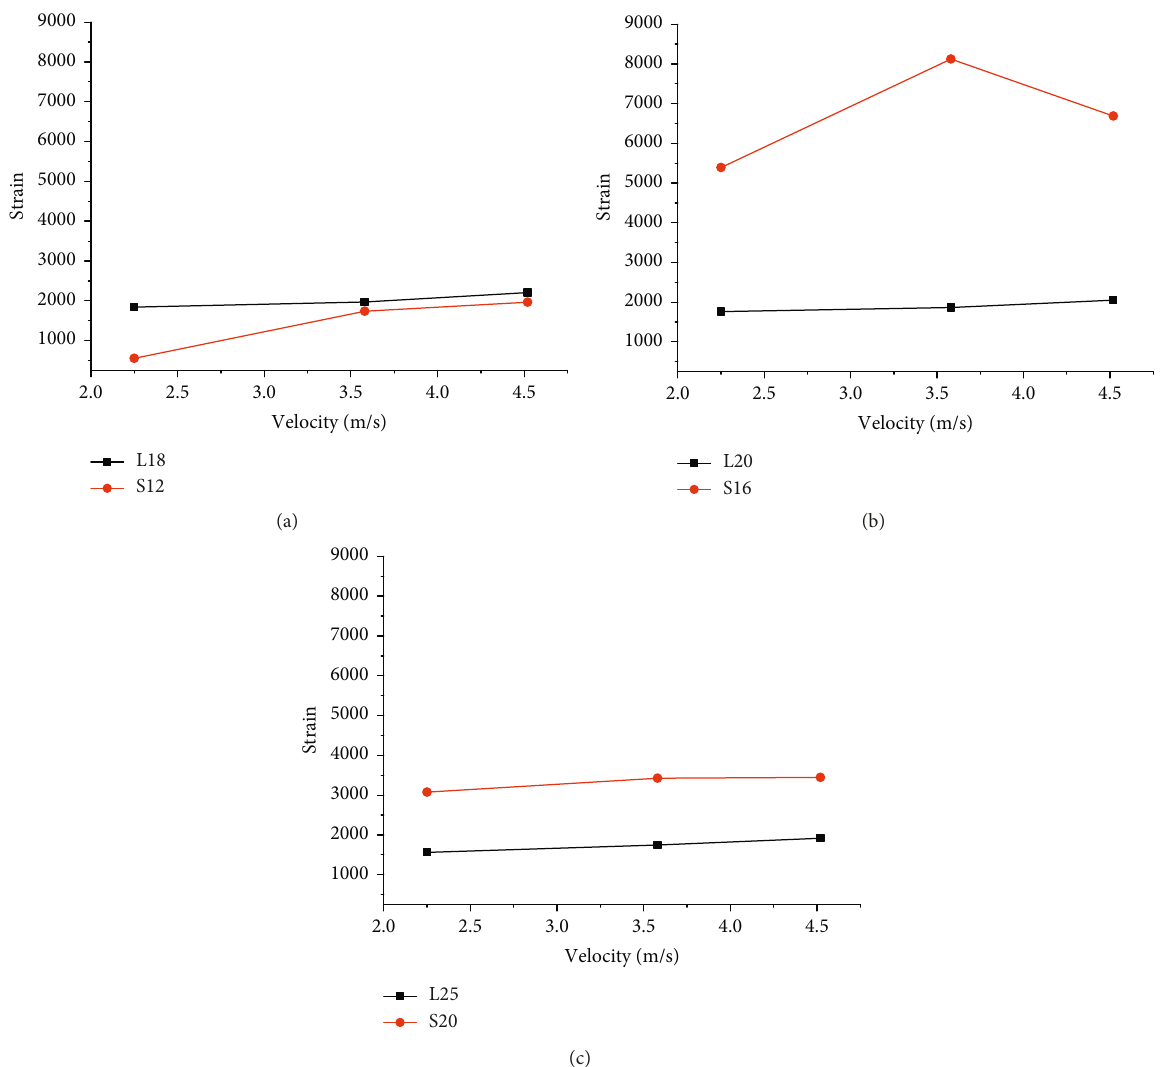
Figure 14: Strain peaks and velocity curves of each specimen group. (a) Group A. (b) Group B. (c) Group